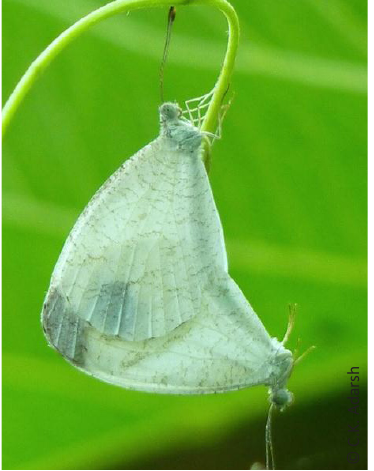
Image 20. Appias Iyncida Chocolate Albatross